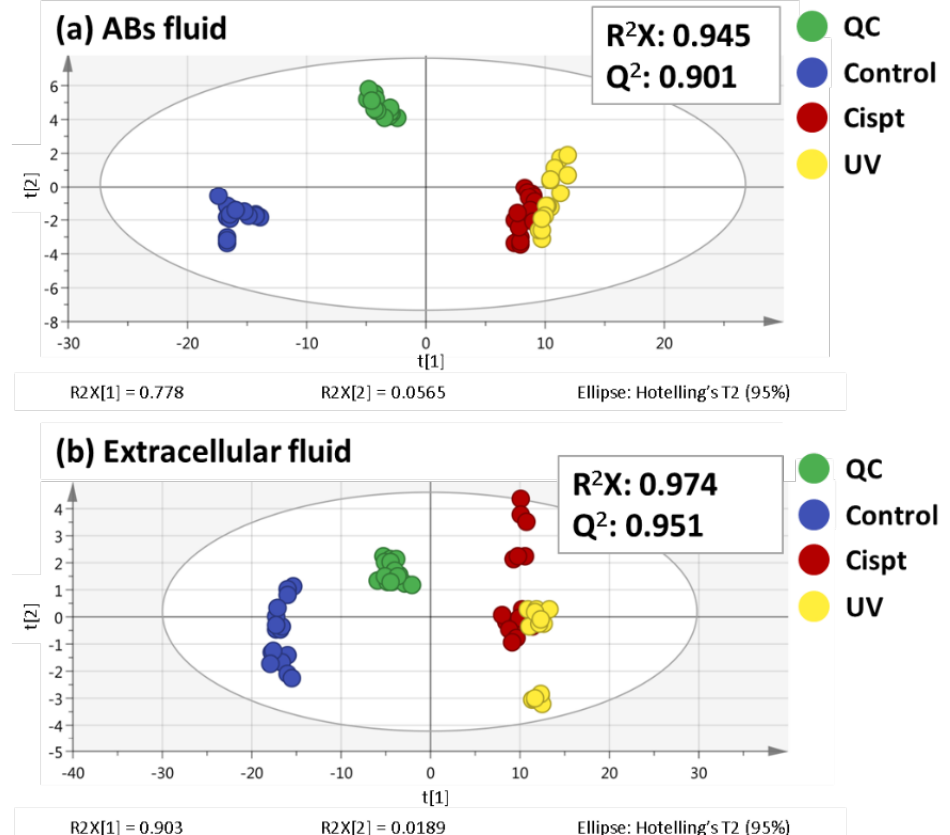
Figure 1. PCA score plots for both ABs fluid ( a ) and extracellular fluid ( b ) analyses. This statistical analysis reduces the dimensionality of the data but preserves the variation present in the original data set as much as possible [12]. In this line, PCA enables us to test the stability of the two sequences and to examine the possible metabolic differences. Previous to the PCA performance, data normalization was a key factor in metabolomic analysis for the data quality and to carry out a correct interpretation of the results. Nevertheless, the normalization methods employed for untargeted metabolomic analysis of EVs are limited and there is not a clear consensus [9]. For example, some of these strategies include protein concentration [13] or particle number [14]. In this way, the method selected in this work was the protein concentration, as detailed in the experimental part. As it can be seen in Figure 1, QC samples appear clustered together in both ABs fluid and extracellular fluid sequences, which showed the high quality and reproducibility of them. The use of QC samples is commonly employed in metabolomics because not only allows to check the system performance, but also to control the equilibration of the analytical system and the signal intensity, among other advantages. On the other hand, a good clustering among the different sample groups can be observed in Figure 1. Particularly in the ABs fluid there was a small, yet noticeable separation between UV- and cisplatin-ABs on the